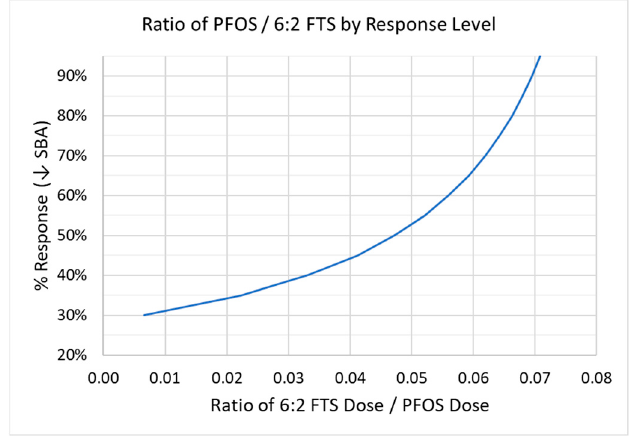
Figure 5. Variability in relative potency (given by the ratio of 6:2 FTS divided by PFOS) by response level, defined as the % reduction in mean SBA. Based on linear D–R models fitted to separate component experiments with PFOS and 6:2 FTS. Table 5. Predicted doses of PFOS and 6:2 FTS (applied individually, rather than as a mixture) that yield the same response (reduction in mean SBA).